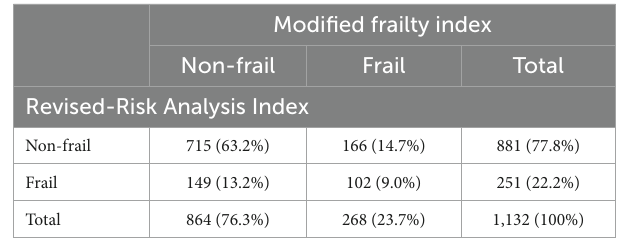
TABLE 3 Two way cross-tabulation of dichotomized mFI and RAI-rev measures.